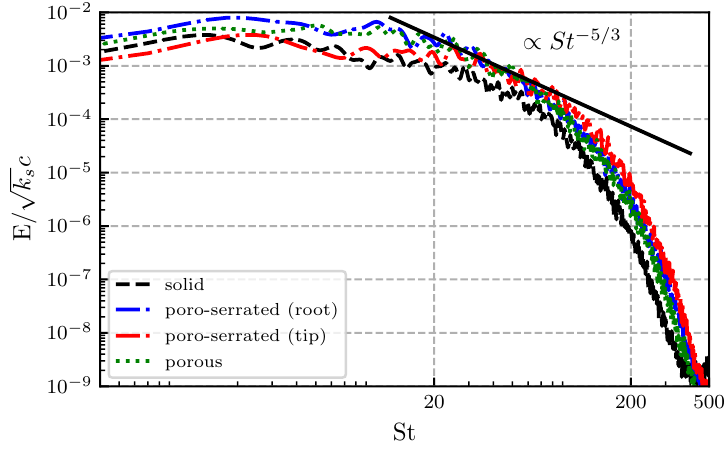
Figure 10. Frequency power spectral density of turbulent kinetic energy k at x / c = 0.0025 on the